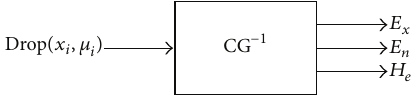
Figure 4: The backward cloud